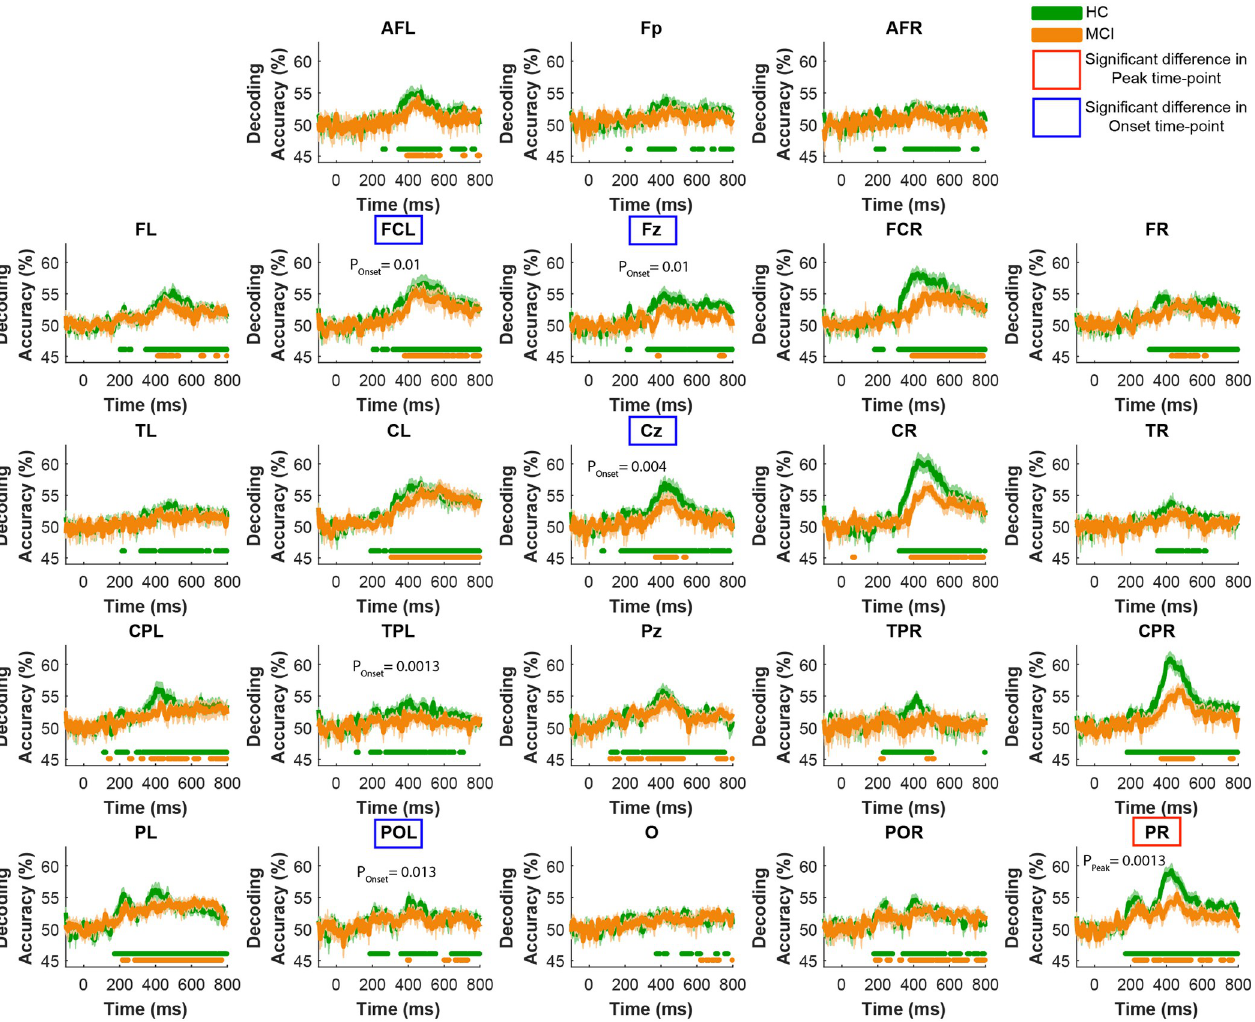
Fig 6. Animal vs. non-animal decoding time course across groups of EEG channels. Horizontal color dots indicate time-points with significant decoding accuracy in the corresponding group (green for HC and orange for MCI). In regions specified with red rectangles MCI’s peak animacy decoding time-point is significantly later than that of HC; in regions specified with blue rectangles MCI’s onset of animacy decoding significance is significantly later than that of HC (FDR-corrected at 0.05; bootstrap test with 10,000 resampling of participants on MCI minus HC